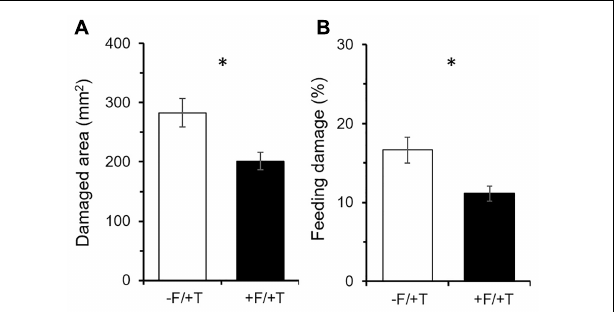
FIGURE 2 | Effects of tomato colonization by the endophyte Fusarium solani strain K (FsK) on the feeding damage inflicted by spider mites ( Tetranychus urticae ). One week after seed sowing plants were either inoculated with the endophyte (black bars, +F) or not (white bars, –F). Subsequently, plants were infested with 30 spider mites (10 mites per leaflet, 3 leaflets per plant, +T) when 4–5 weeks-old for a period of 10 days. Mean ± SE ( n = 8) of the (A) damaged area per plant and (B) proportion of damaged to total leaflet area inflicted by spider mites on FsK-colonized compared to control plants over a period of 10 days. Significant differences between treatments are indicated by asterisks after Student’s t -test: ∗ P <